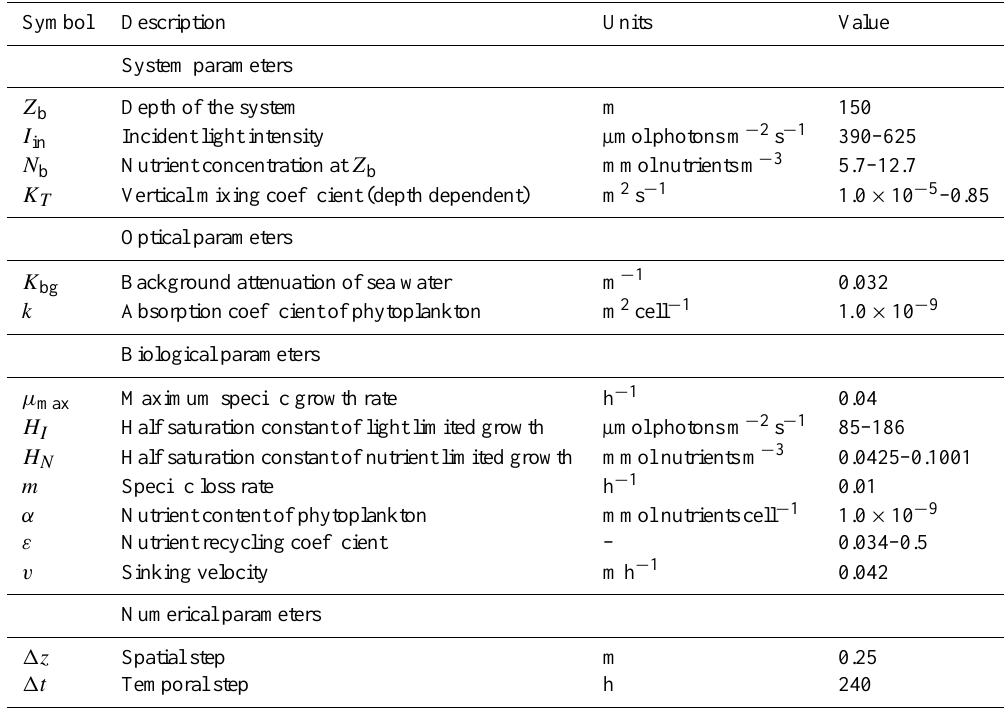
Table 1. Standard values used in the